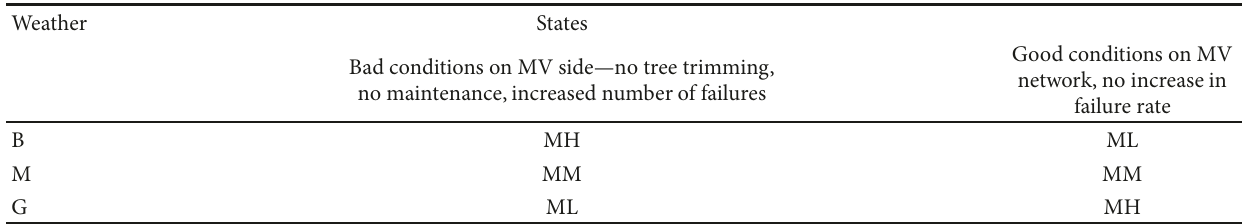
Table 4: Conditional probabilities of network conditions.